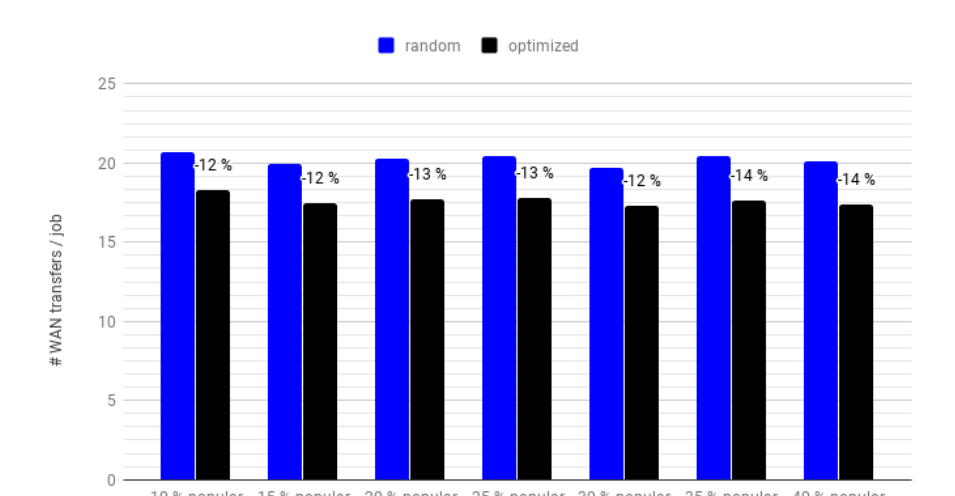
Figure 2. Runs with 20 data centers comprising di ff erent job configurations in terms of used data